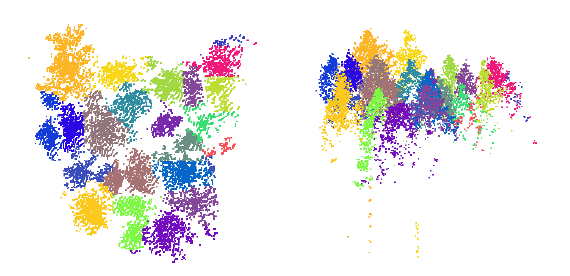
Figure 5. Top and the front of Plot E segmented using Method 1 (calibrated), with each separate tree assigned a random colour.